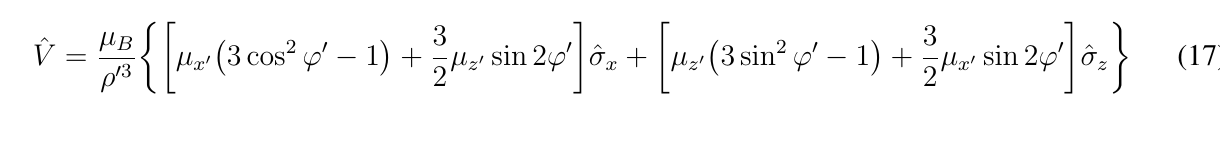
Figure 1. The coordinate systems: ( x, z ) and ( x (cid:48) , z (cid:48) ). The x (cid:48) -axis is parallel to (cid:126)q